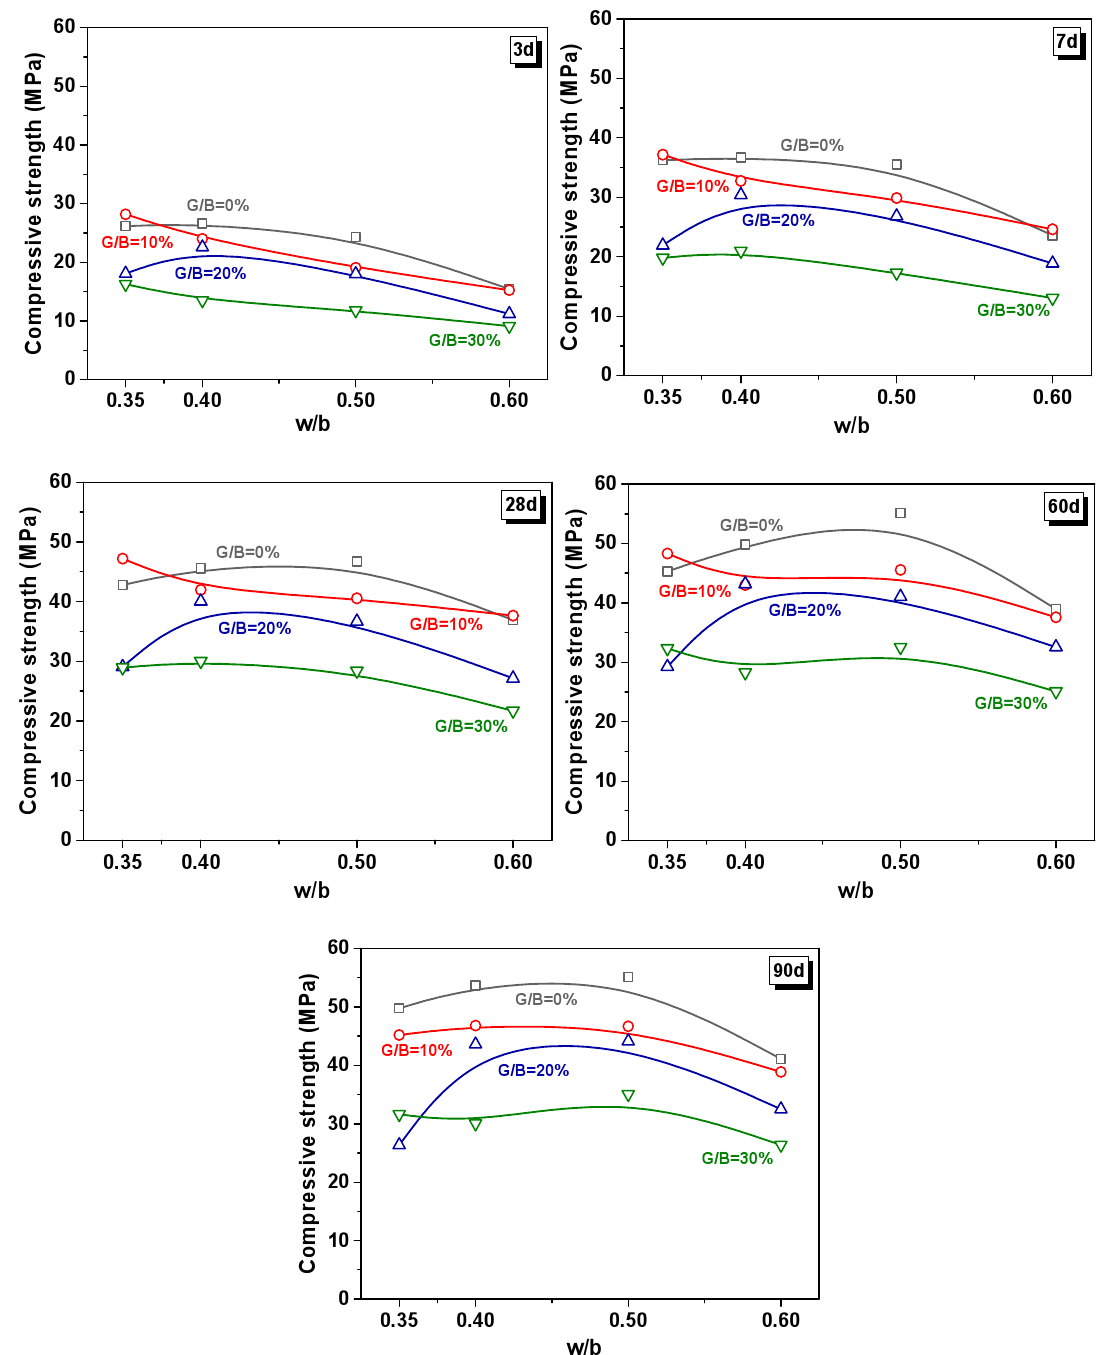
Figure 7. The relationship between the w/b ratio and G/B ratio at different curing ages.